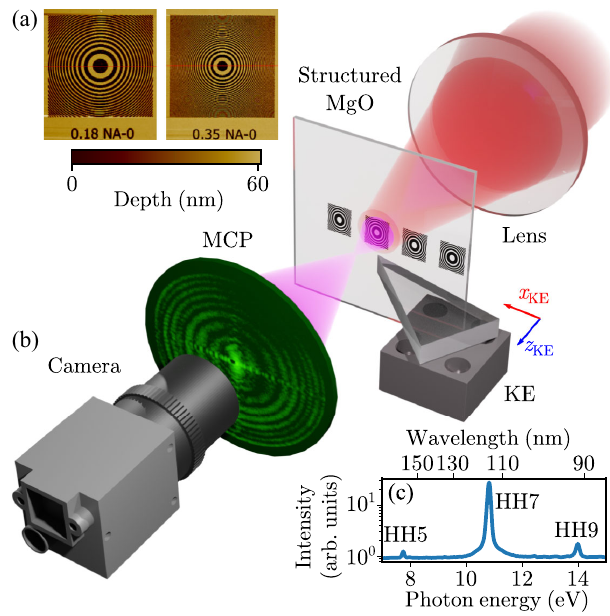
FIG. 1. (a) Atomic-force-microscope images of the two zone plates utilized in this study. They consist of rings etched in the MgO surface. Color scale represents surface depth. (b) The beam of an 800-nm laser is focused with a spherical lens onto a MgO crystal, with zone-plate patterns etched on its exit surface. The emitted high-harmonic radiation is captured on an imaging microchannel plate detector (MCP) equipped with a phosphor screen. The XUV yield is measured either as an electrical current on the MCP or as light flashes on the phosphor screen, imaged with a CCD camera. The shard of glass that acts as knife edge is mounted on a 2D nanopositioner (Micronix PPS20, 2-nm resolution) near the zone plate ’ s focus. The knife edge (KE) can be moved normal to (axis z ) and along (axis x ) the sample surface. (c) High-harmonic spectrum emitted by the MgO surface and measured with a conventional XUV spectrometer consisting of a flat-field grating and MCP detector. The spectrum is dominated by the seventh harmonic (114-nm